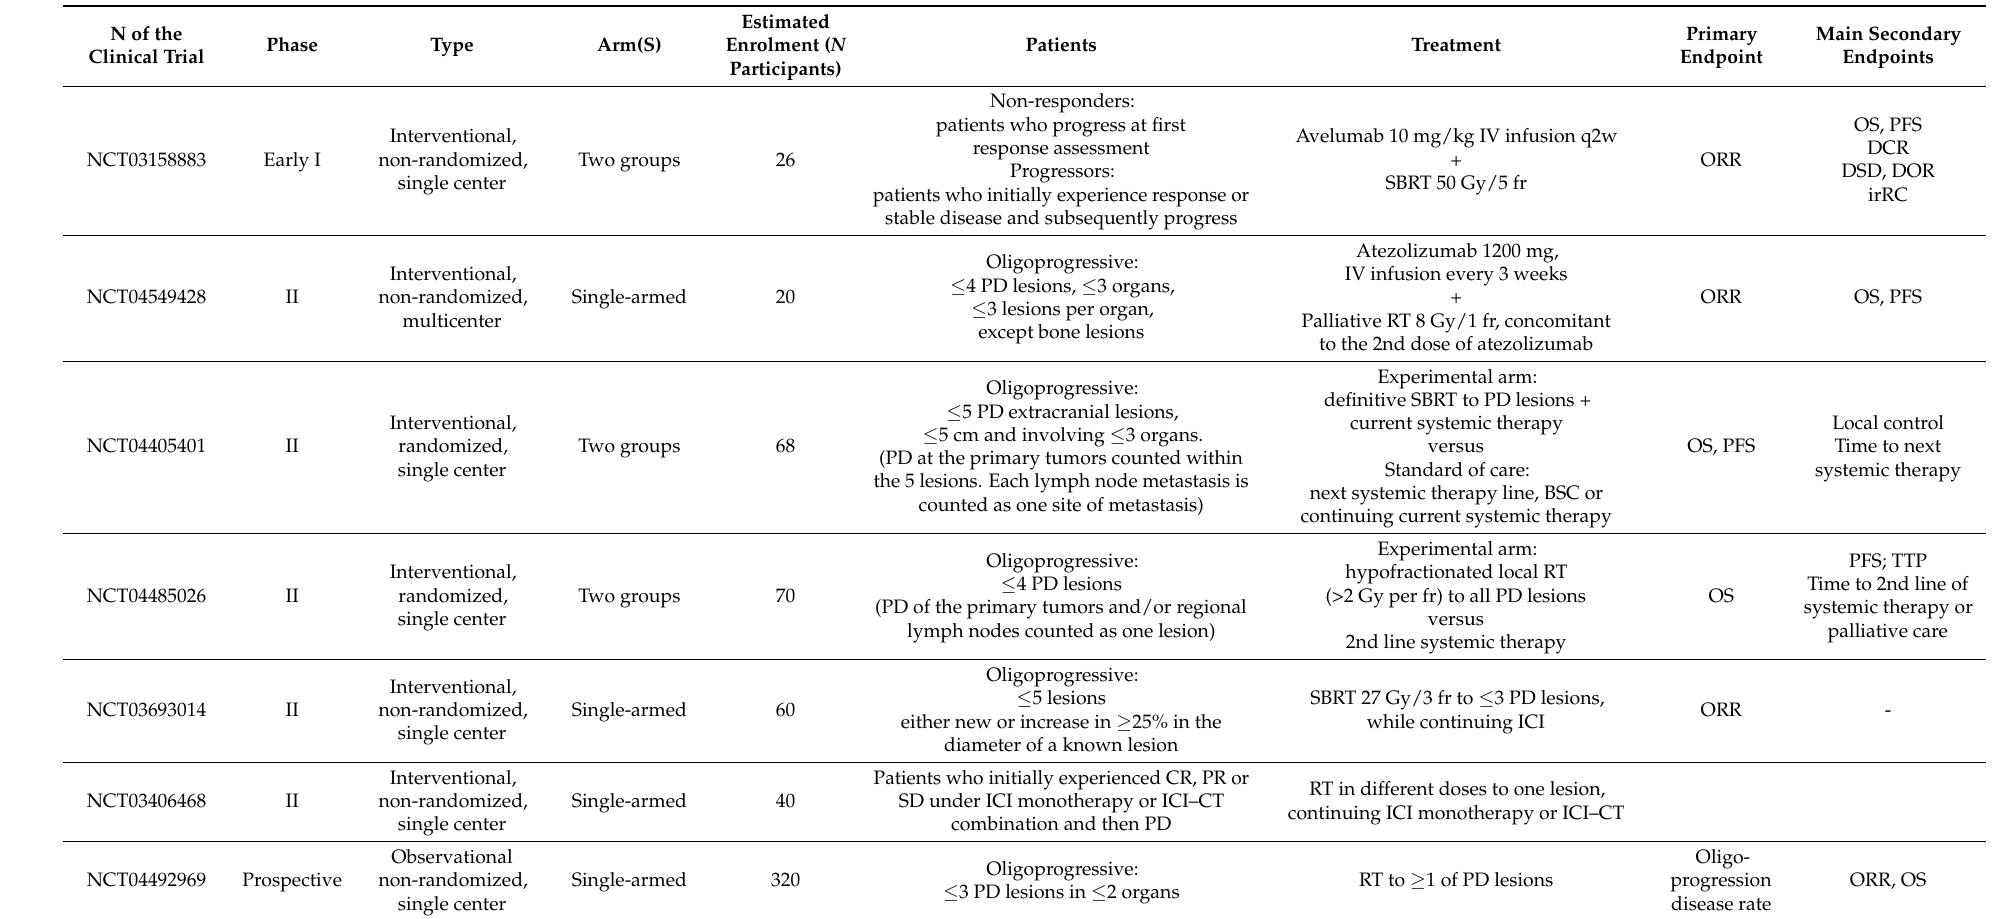
Table 2. Ongoing trials on LAT in advanced NSCLC patients who progressed on